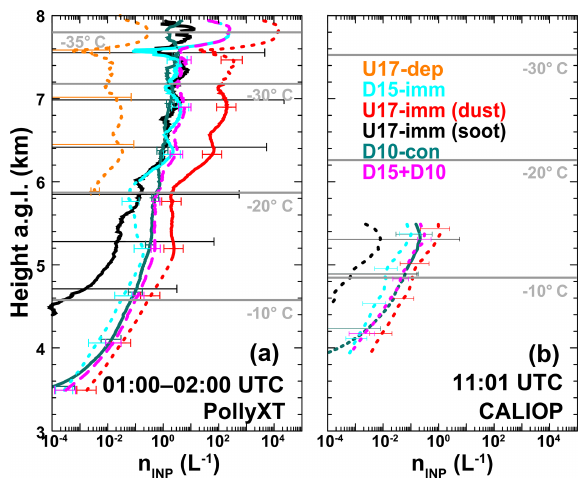
Figure 11. INP concentration profiles estimated from the measure- ments with (a) PollyXT between 01:00 and 02:00UTC on 21 April 2016 and (b) CALIOP at 11:01UTC on 21 April 2016. Temperature levels are derived from the WRF and MERRA-2 models. Colors re- fer to different INP parameterizations. Solid lines mark the temper- ature range for which the corresponding parameterization has been developed. Dashed lines refer to the extrapolated temperature range (see Table